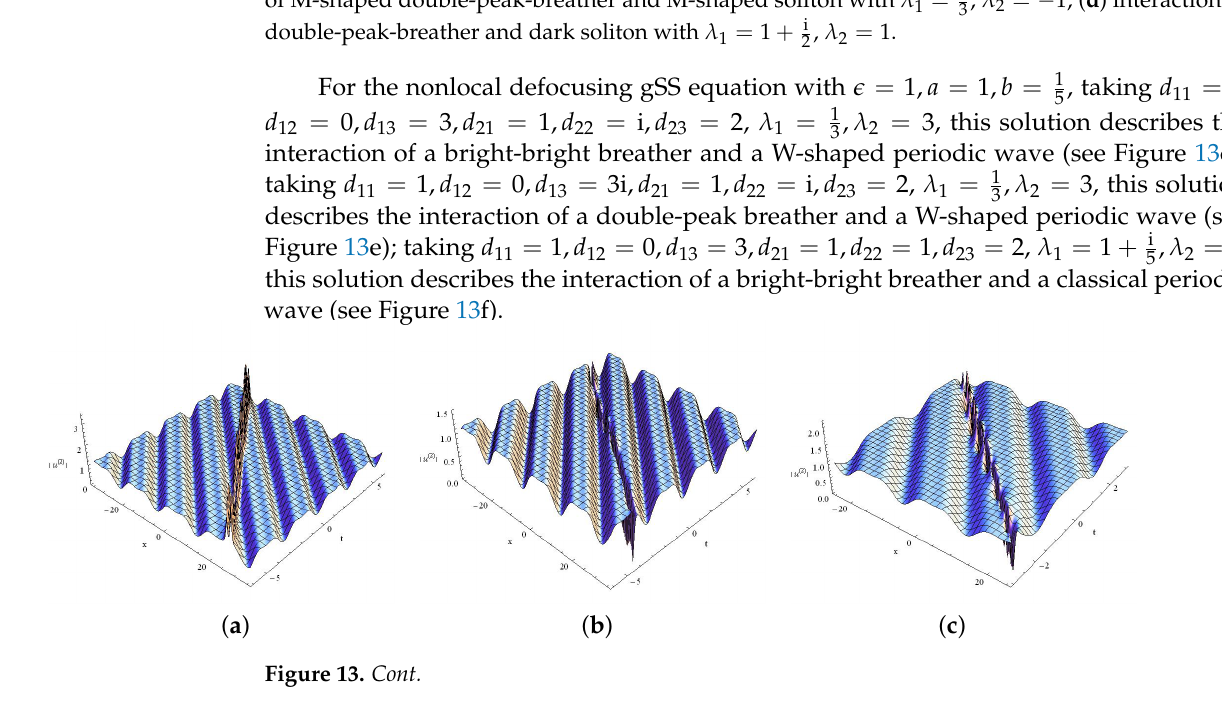
, λ 2 = 1; ( b ) interac- 3 , λ 2 = 1 ; ( c ) interaction 3 2 , λ 2 = − 1; ( d ) interaction of 3 , λ 2 = 1. 2 , taking d 11 = 1, 5 , λ 2 = 3, this solution describes the 3